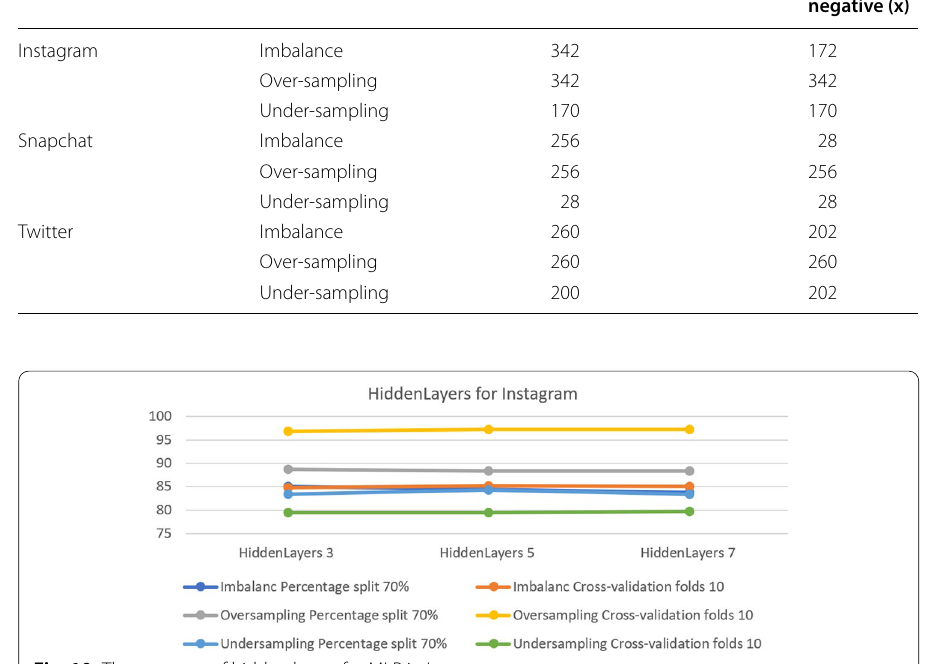
Fig. 10 The accuracy of hidden layers for MLP in